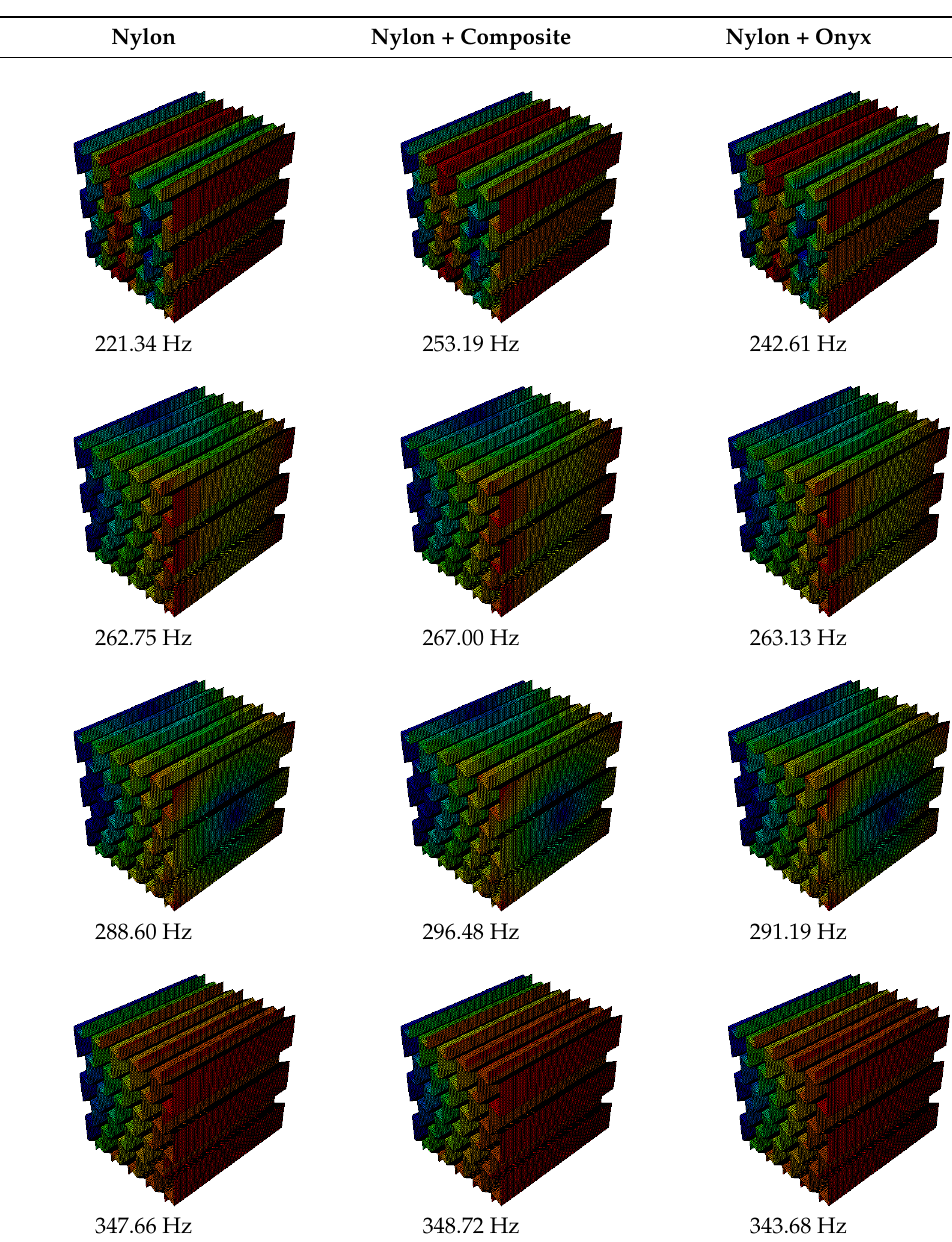
Table 14. Cont. Nylon Nylon + Composite Nylon +